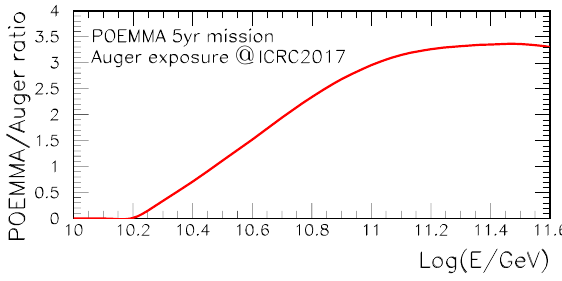
Figure 7. The 5 year POEMMA stereo UHECR exposure for a satellite separation of 300 km, assuming a 10% duty cycle, in terms of 14 years of Auger exposure [14]. From Ref. [16].